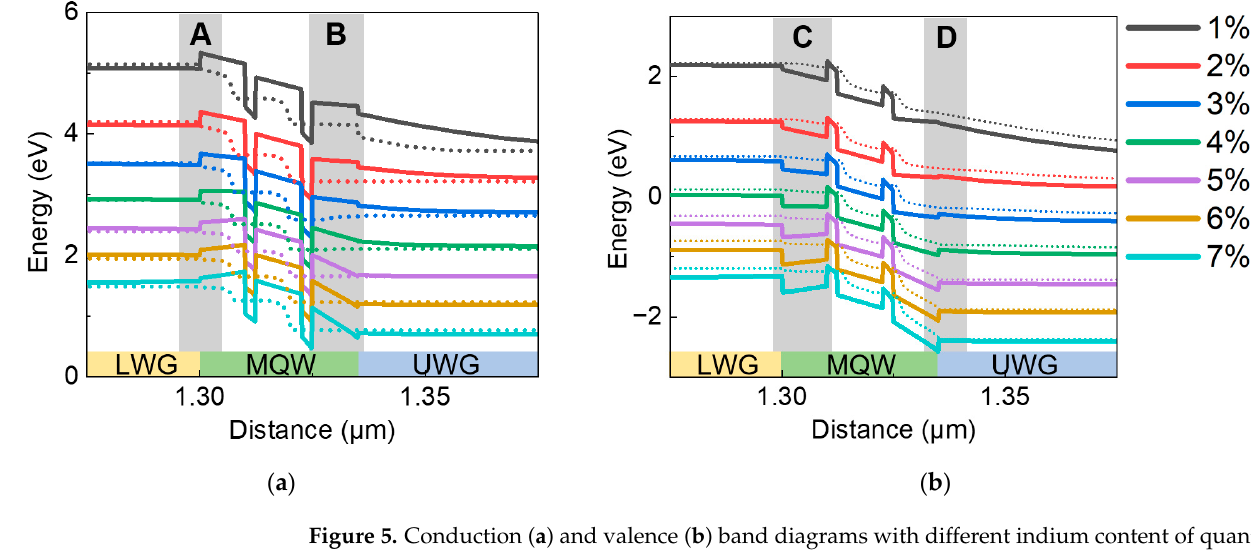
Figure 5. Conduction ( a ) and valence ( b ) band diagrams with different indium content of quantum barriers in the MQW region at an injection current of 1000 mA. In these figures, A, B, C, D represent potential barrier heights for electron injection, electron leakage, hole leakage and hole injection, respectively. (Solid lines represent conduction and valence bands, and dashed lines represent the position of quasi-Fermi level. The band curves of samples with different indium content are vertically shifted by 0.5 eV in sequence for easy eye view).